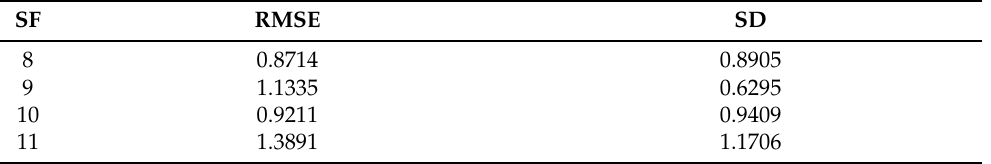
Table 4. Uplink Neural Network